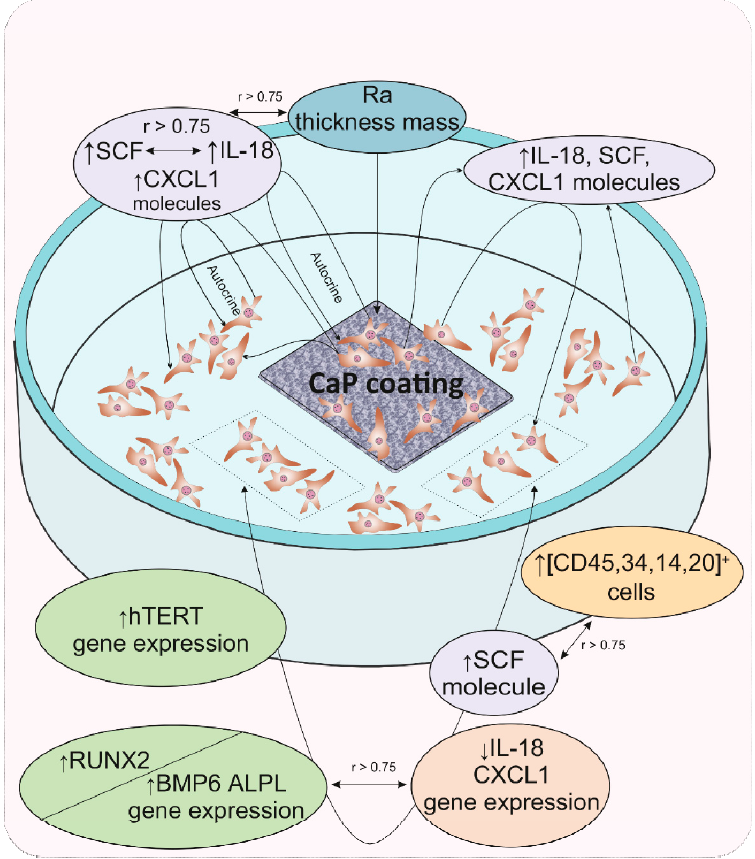
Figure 3. Schematic representation summarizing the main results of gene expression regulation in and secretory activity of mesenchymal stem cells after 14 days of in vitro contact with the microarc CaP coating on a titanium substrate. Abbreviations are presented in the text of the article and in Table